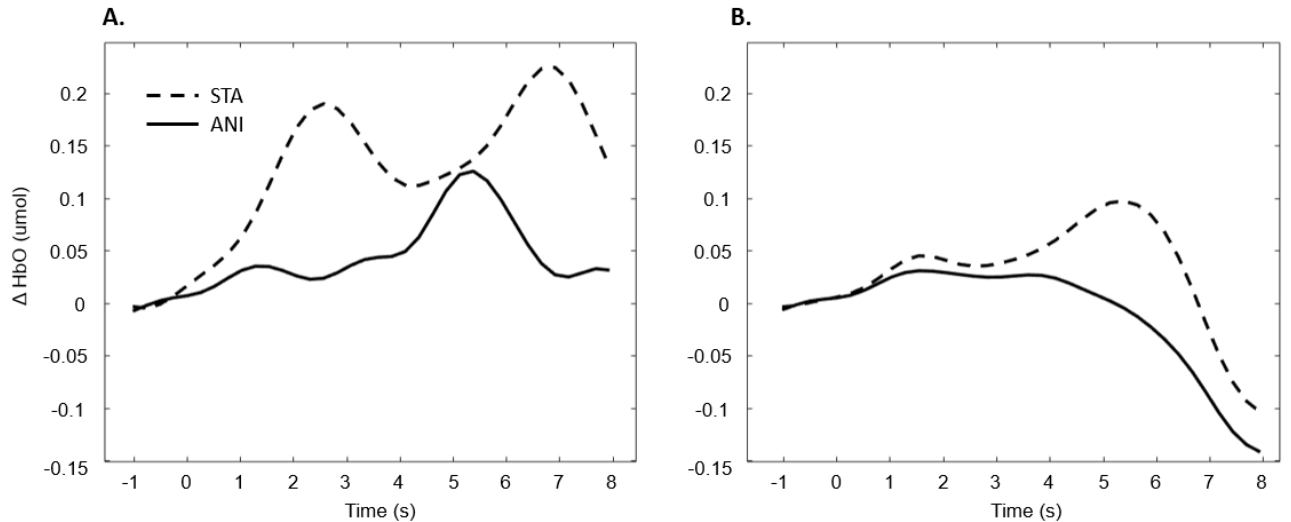
Figure 9. Average of the hemodynamic evoked response in the deaf group ( A ) and hearing group ( B ) for the two conditions in the central region, which is involved in clocking mechanism.